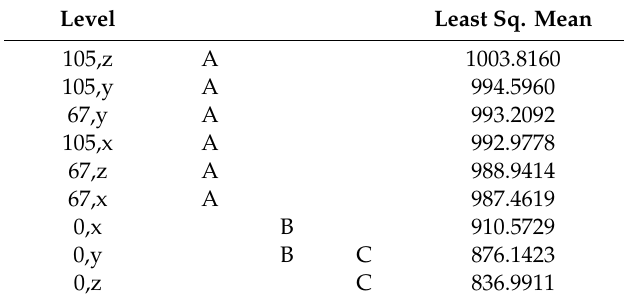
Table 12. LSMeans Di ff erences Tukey HSD (flow stress at 35% plastic strain); α =